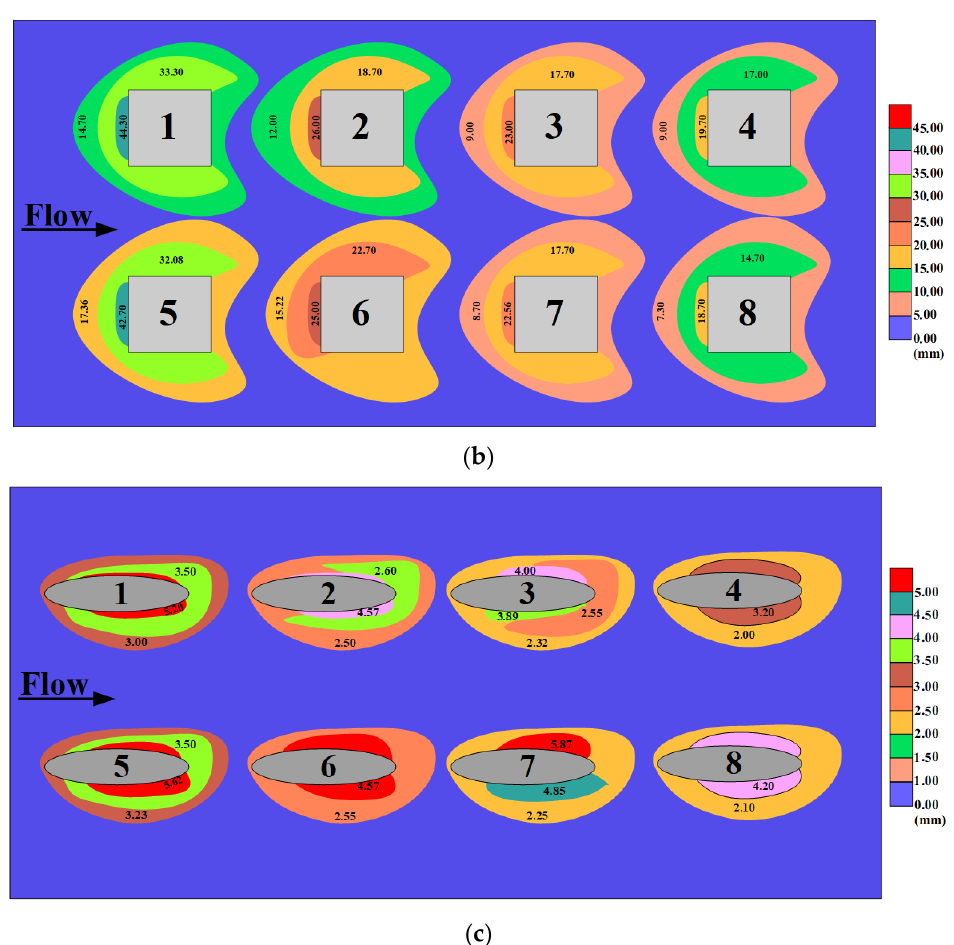
Figure 8. Scour depths contours for pile group: ( a ) circular; ( b ) square; ( c ) lenticular.